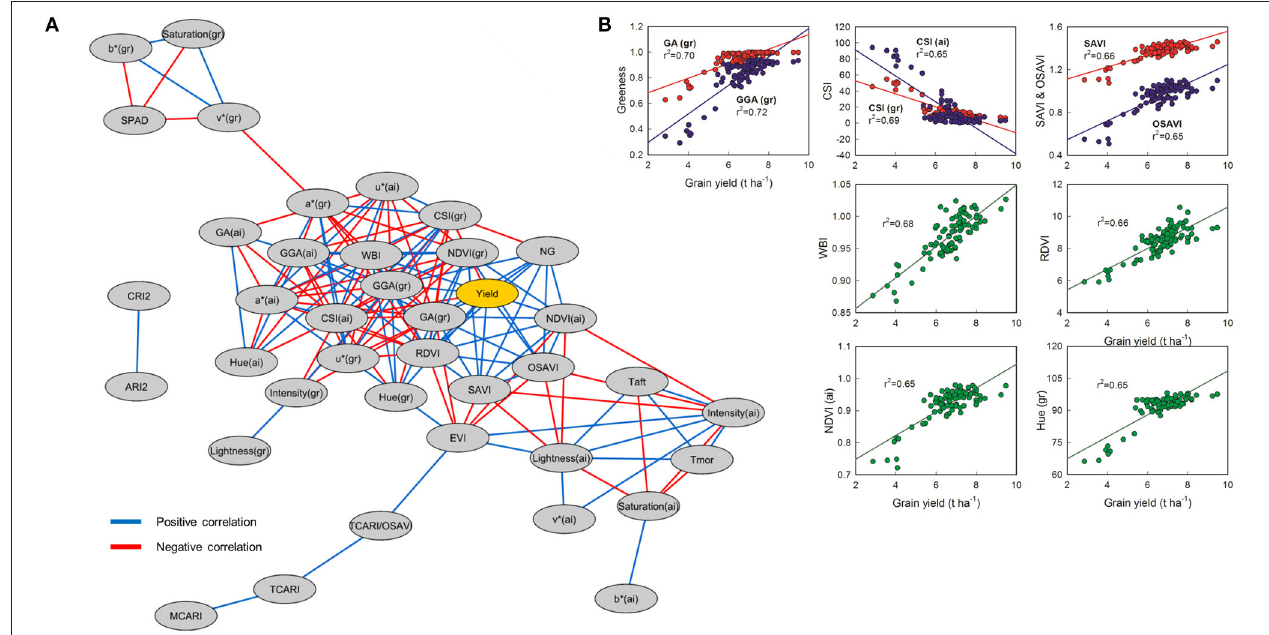
FIGURE 5 | (A) Correlation network for physiological traits in barley using three different genotypes and ten nitrogen treatments. Edge color represent positive correlations between traits in blue (Pearson’s r > 0.6; P < 0.001) and negative correlations in red (Pearson’s r < − 0.6; P < 0.001). All the significant correlations between yield and other traits are shown in (B) ( n = 90).